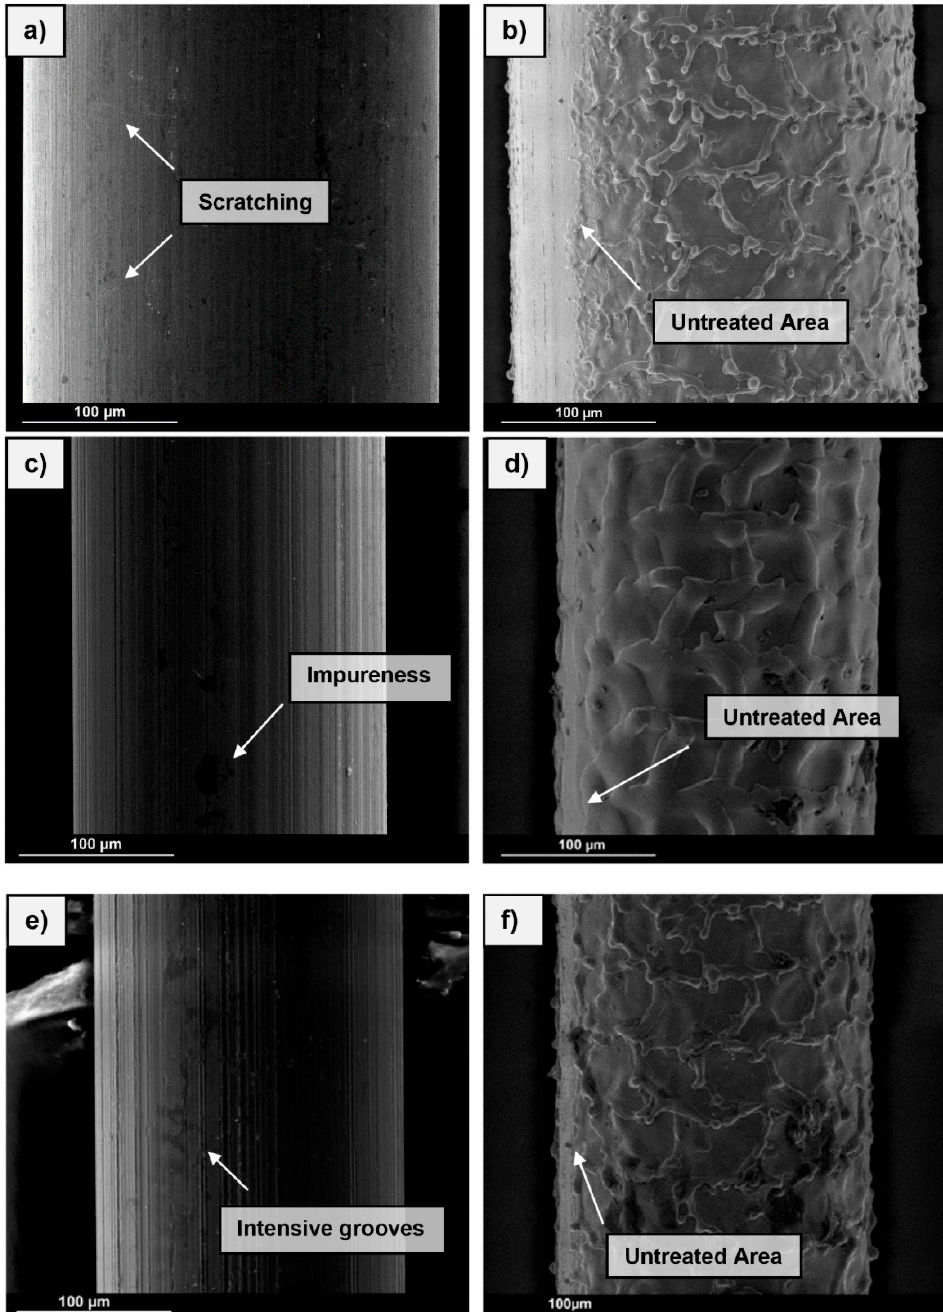
Figure 4. Secondary electron images of the fibre types before the fibre pullout tests. ( a ) Surface of the steel fibres. ( b ) Surface of the steel fibres after roughening. ( c ) Surface of the NiTi-fibres. ( d ) Surface of the NiTi-fibres after roughening. ( e ) Surface of the stainless-steel fibres. ( f ) Surface of the stainless-steel fibres after roughening.